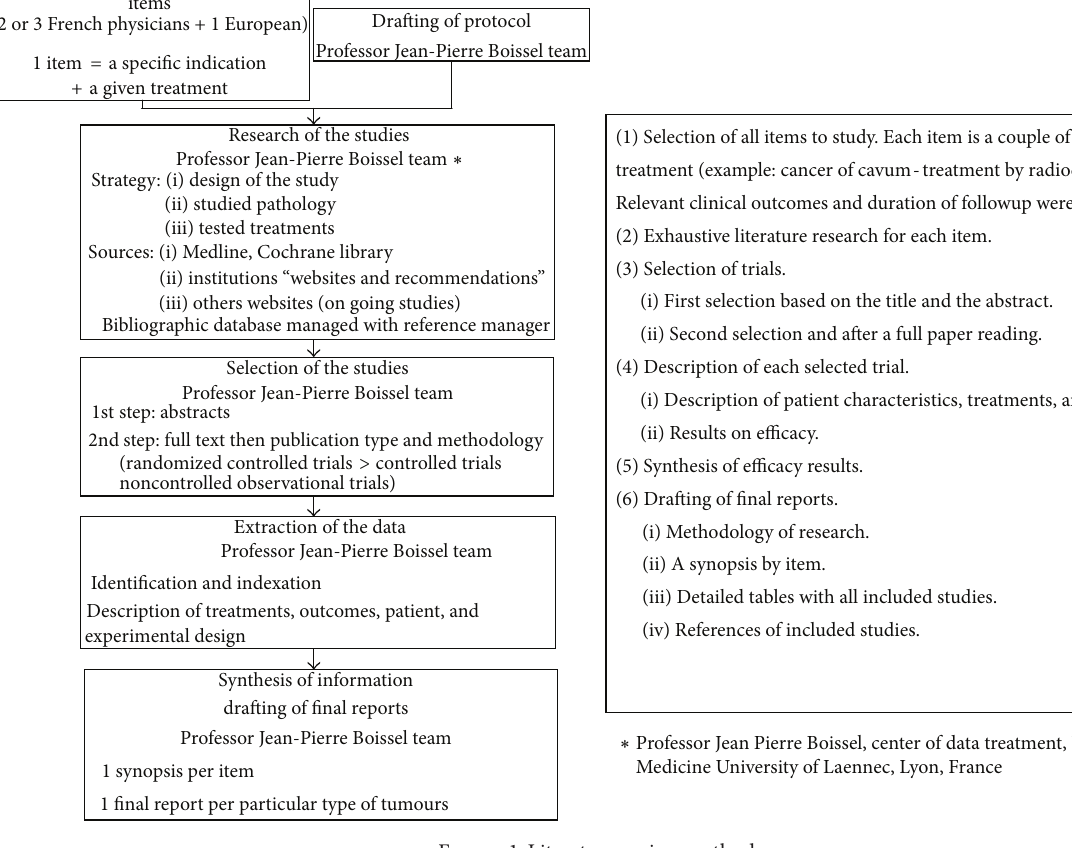
Figure 1: Literature review